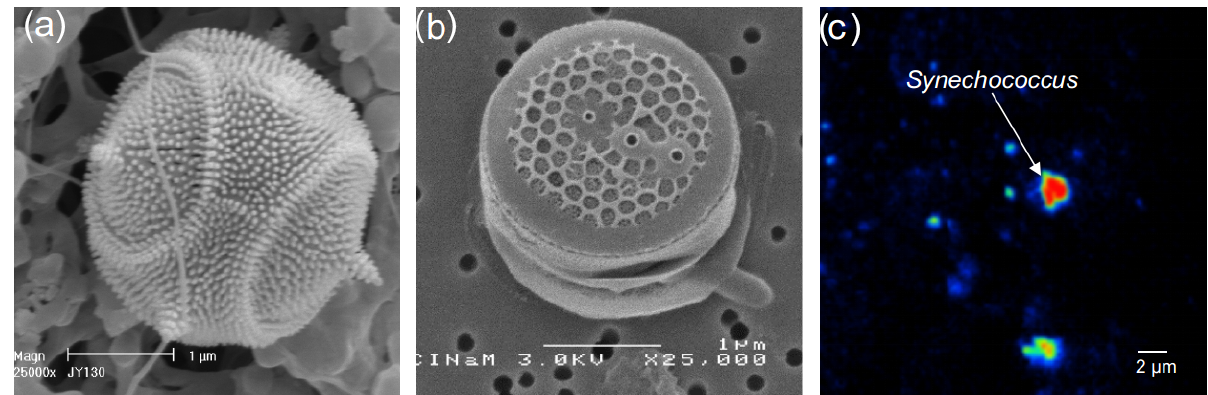
Figure 11. Potential siliceous organisms in the picoplanktonic ( < 2–3µm) size fraction. (a) Siliceous scale-bearing Parmale ( Tetraparma pelagica in SEM, photo courtesy of J. Young), (b) centric diatom ( Minidiscus trioculatus ), (c) Synechoccocus cell showing Si assimilation in red ( 28 Si) in NanoSIMS (photo courtesy of Mathieu